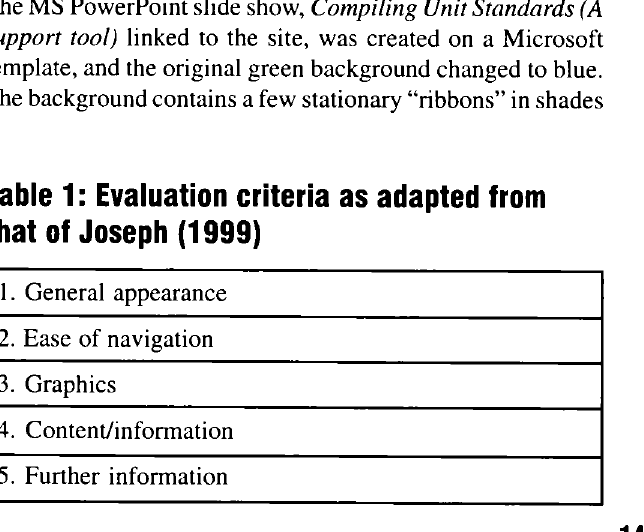
Table 1 : Evaluation criteria as adapted from that of Joseph